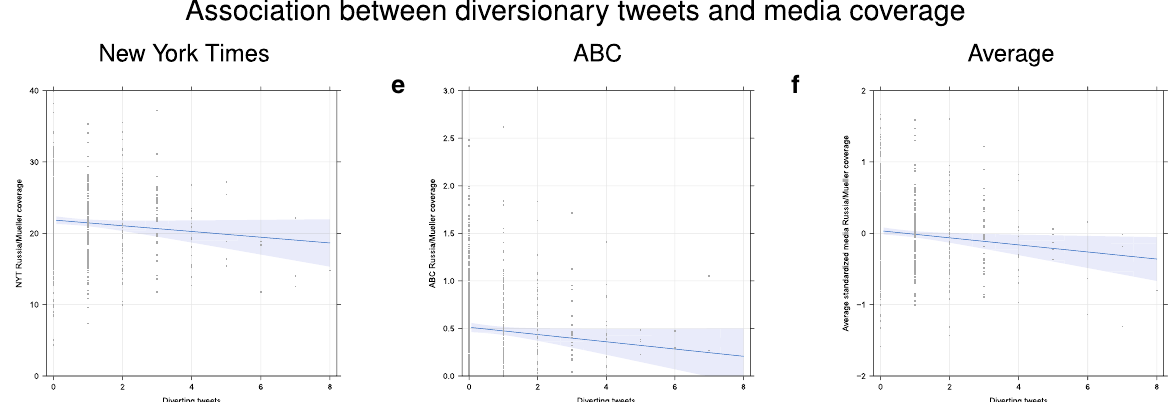
Fig. 2 Association between media coverage of Russia/Mueller and diversionary tweets (top row of panel), and association between diversionary tweets and subsequent media coverage (bottom row of panels). NYT is shown in panels ( a , d ); ABC news in panels ( b , e ); and the average of the two in panels ( c , f